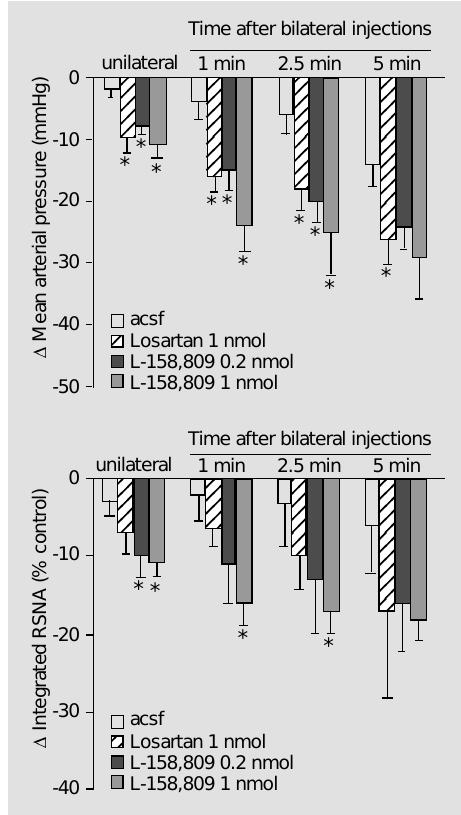
Figure 6 - Histogram summaris- ing the effects of unilateral and bilateral injections into the ros- tral VLM of either artificial cere- brospinal fluid (acsf, N = 6) or the AT 1 receptor antagonists lo- sartan (1 nmol, N = 6) or L- 158,809 (0.2 nmol, N = 6 or 1.0 nmol, N = 7) on arterial pressure and renal sympathetic nerve ac- tivity (RSNA). In all cases the GABA receptor antagonist bicu- culline had been injected bilater- ally into the rostral VLM approxi- mately 10 min before the injec- tions of these different com- pounds. *P<0.05 for the effects of losartan or L-158,809 com- pared with that of the vehicle solution